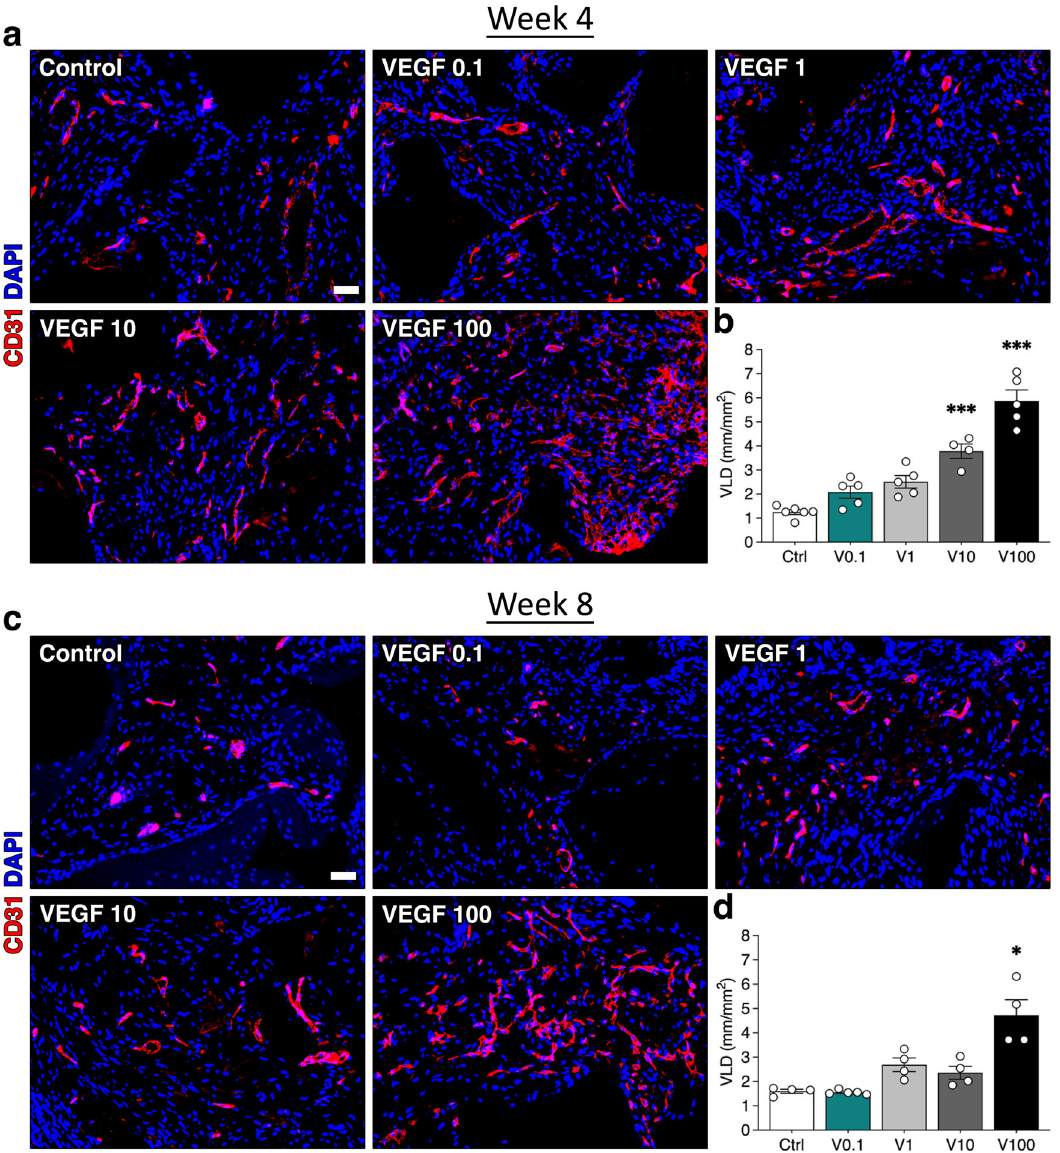
Fig. 4 Long term vascularization of osteogenic constructs. a , c Immunostaining of endothelium (CD31, in red) and nuclei (DAPI, in blue) of constructs, with TG-VEGF doses ranging from 0 to 100 µg/ml, after 4 ( a ) and 8 ( c ) weeks of in vivo implantation. b , d Quanti fi cation of vessel length density (VLD), expressed as millimeters of vessel length per square millimeter of tissue area (mm/mm 2 ) after 4 ( b ) and 8 ( d ) weeks of in vivo implantation. Values are expressed as mean ± s.e.m.; * p < 0.05, *** p < 0.001. N = 4 – 6. Scale bars = 100 μ